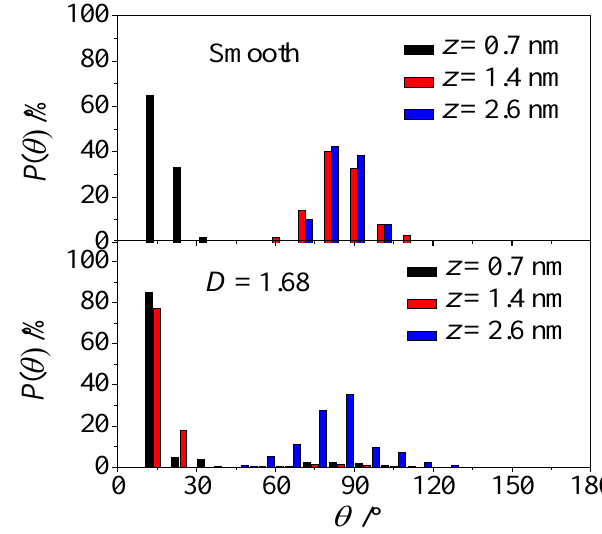
Figure 6. Probability density function of water molecule orientations.